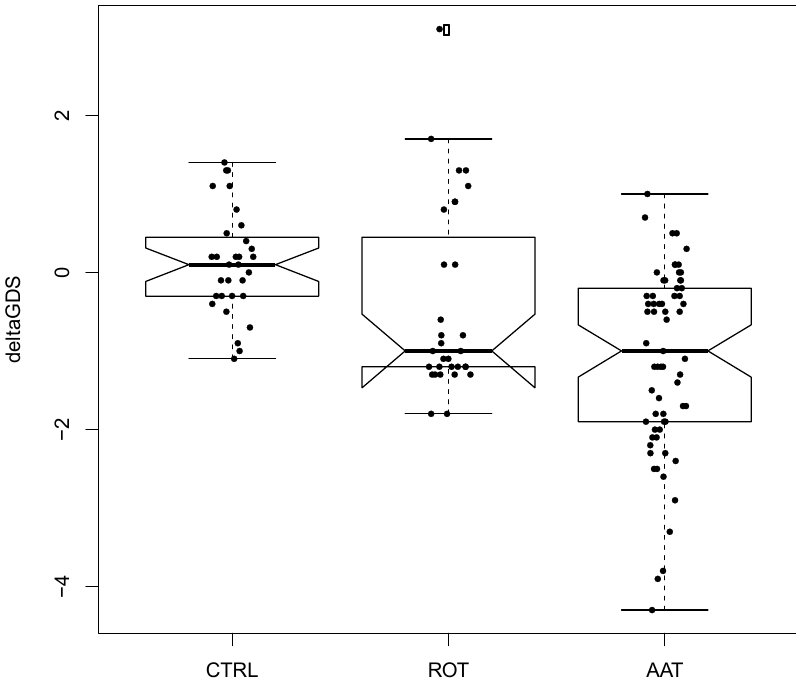
Figure 1. Boxplot of differences before and after treatment for Geriatric Depression Scale (GDS). Each black dot is a patient. Empty circles are outliers with respect to the main distribution. Horizontal solid line represents the median of distribution. Abbreviations: CTRL = control; ROT = reality orientation therapy; AAT = animal-assisted therapy.